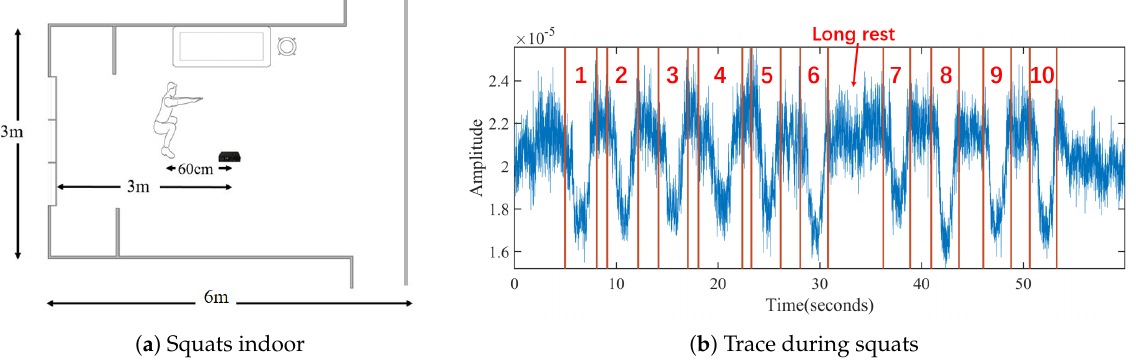
Figure 1. Application scenario of MobiFit and the collected data trace during ten squats with segmentation result